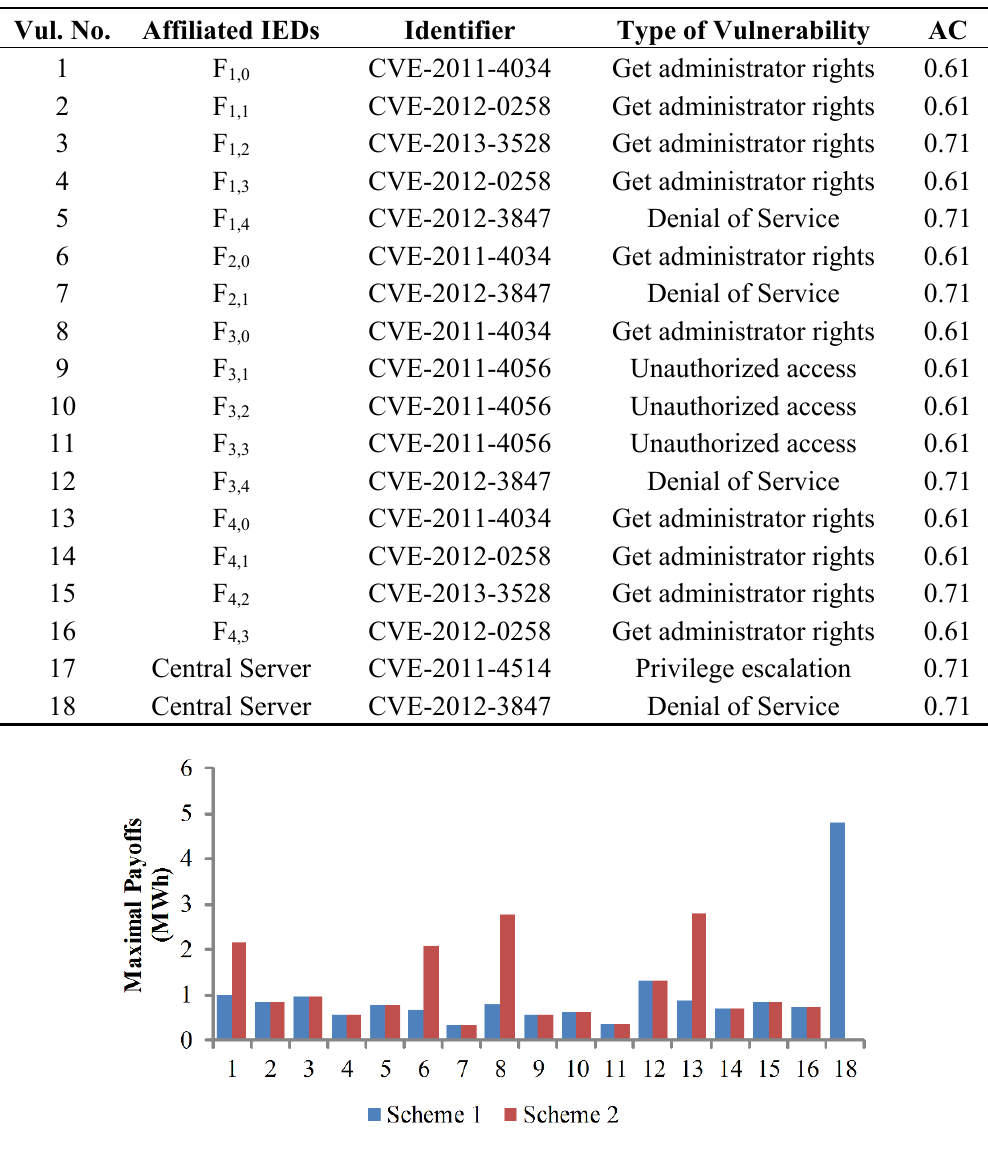
Figure 6. Maximal payoffs of attacking different